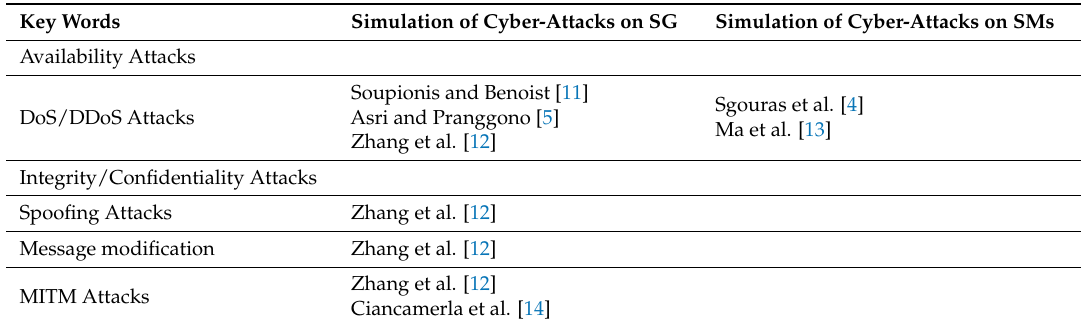
Table 1. Related work: simulation of cyber-attacks.